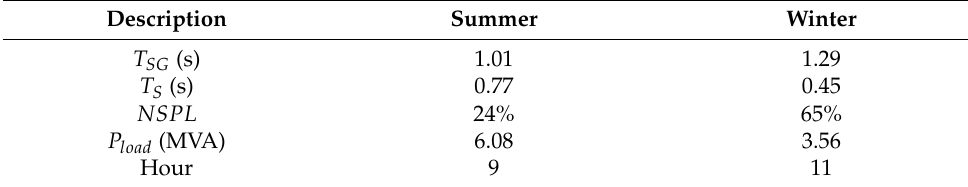
Table 4. Parameters for the considered case study.